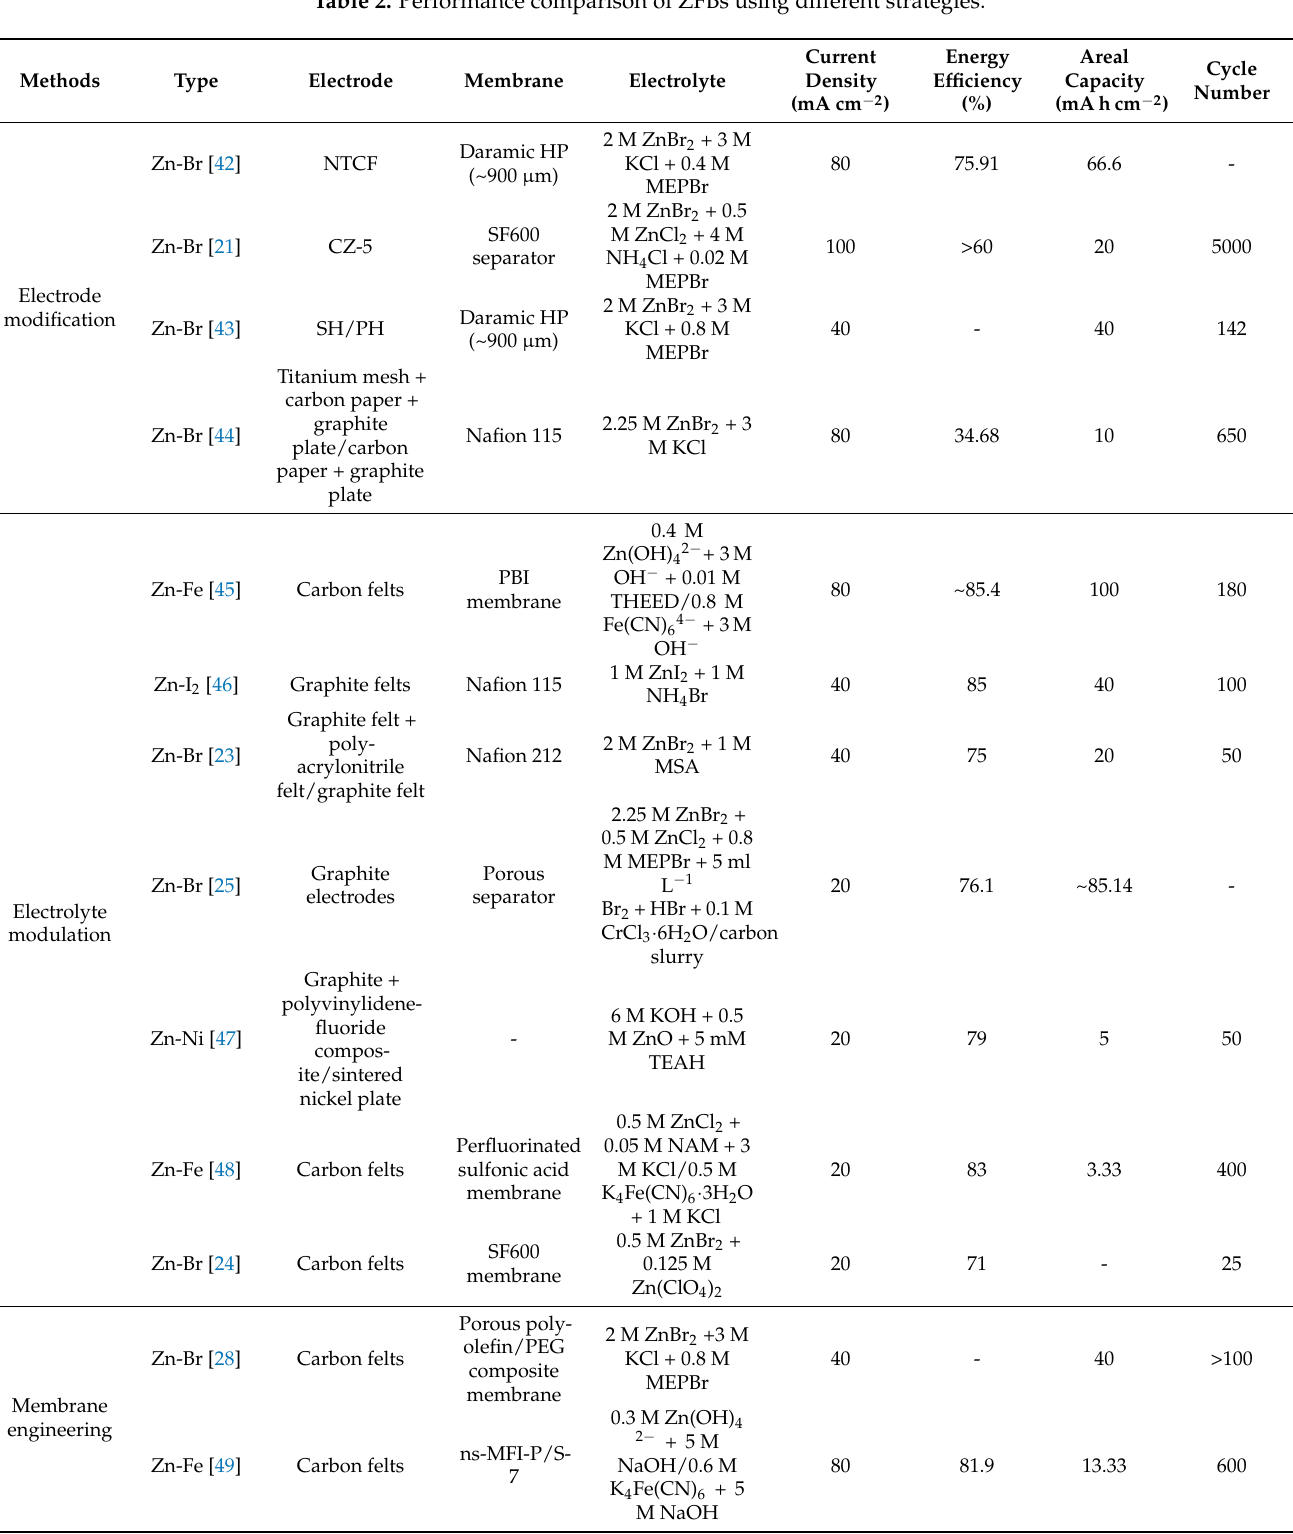
Table 2. Performance comparison of ZFBs using different